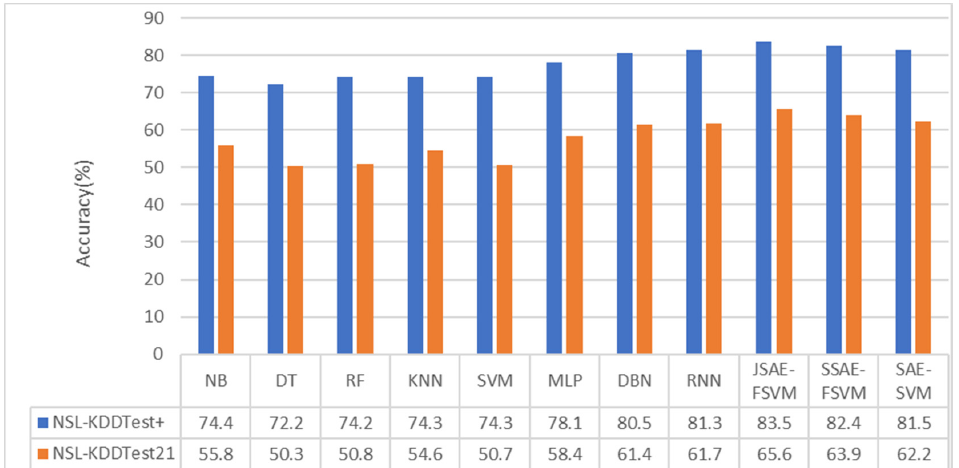
Figure 7. Five-category classification accuracy.